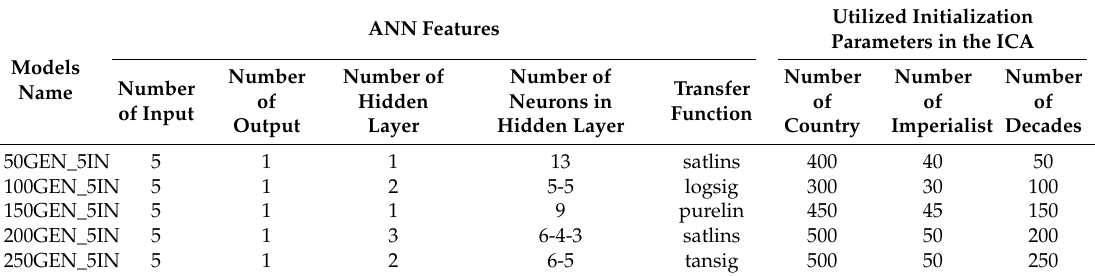
Figure 3. The structure of the ICA-ANN used in the analysis. Table 3. Optimized structure of the ICA-ANN.